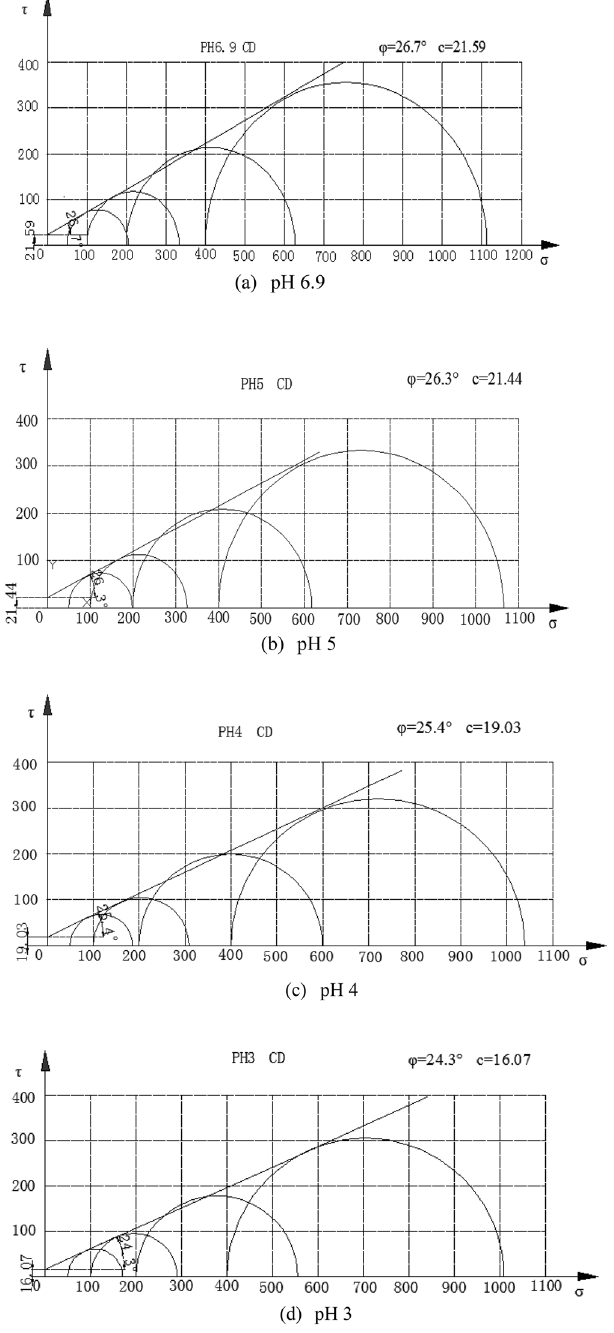
Figure 6. The Mohr stress circle of loess samples under acid rain